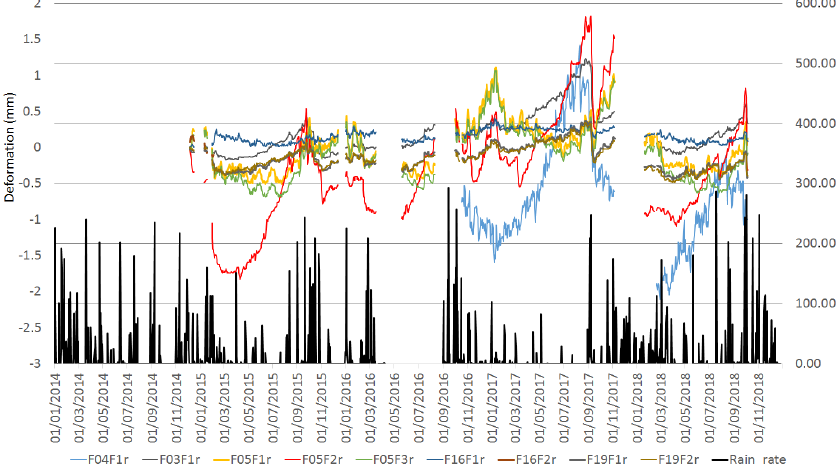
Figure 22. Comparison between crackmeter measurements and maximum daily rain rate data time series.